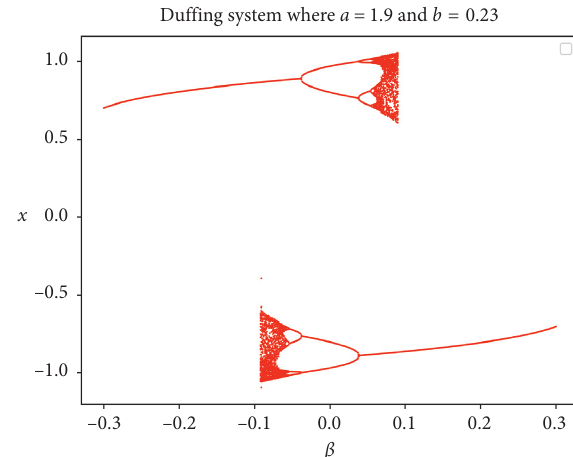
Figure 21: Bifurcation diagram of β .